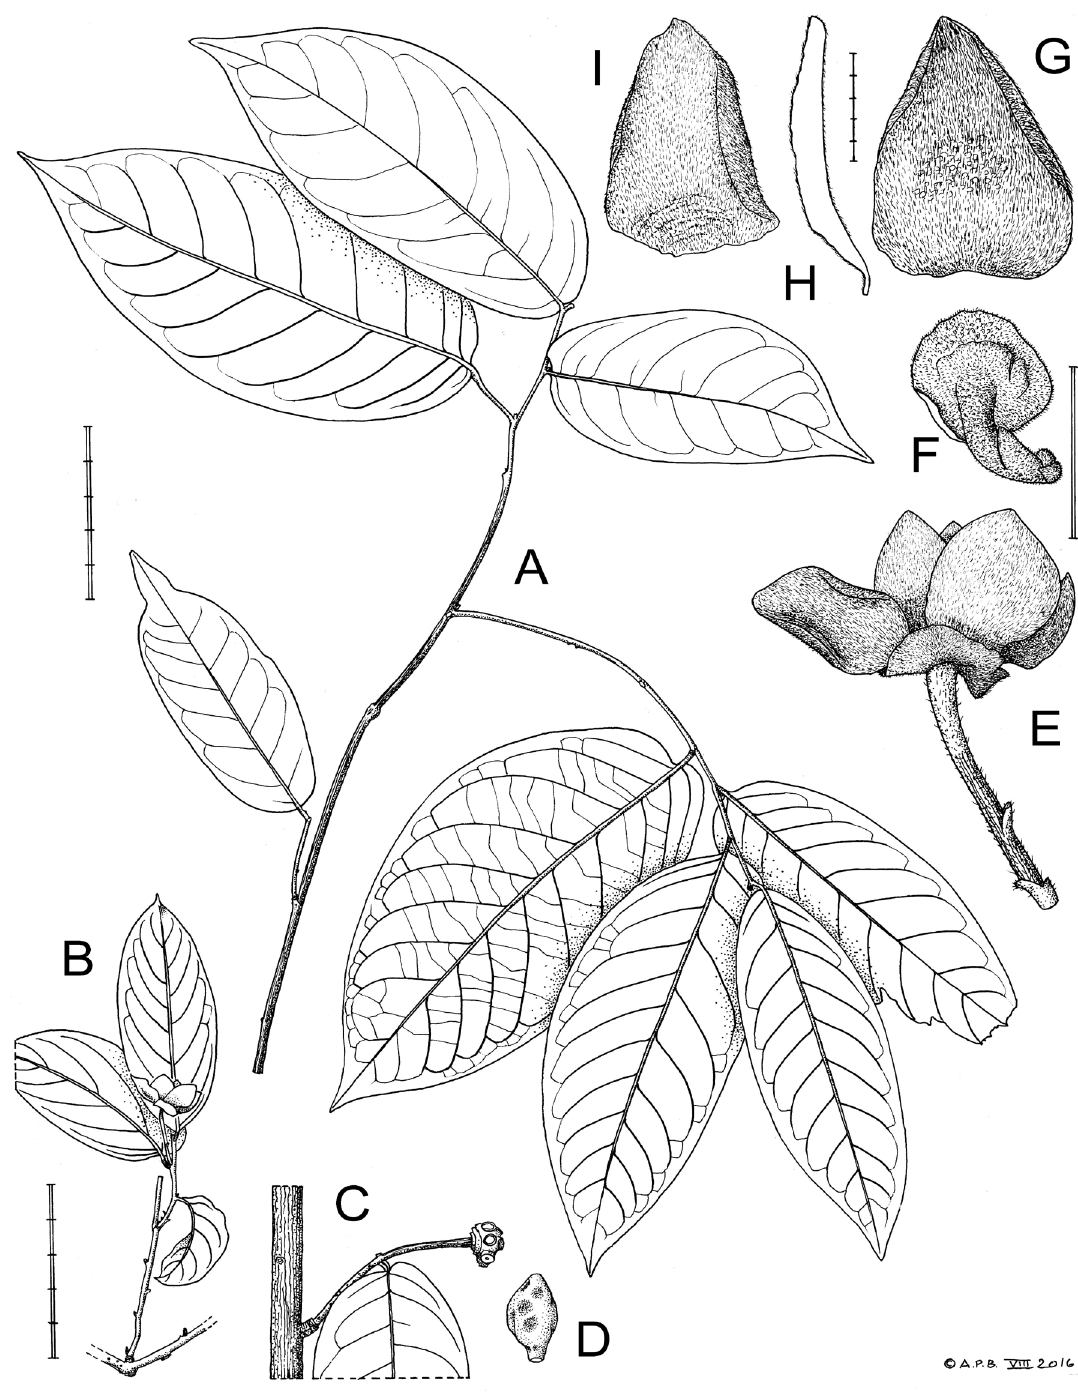
Fig. 1. Monoon pachypetalum I.M.Turner & Utteridge sp. nov. A . Foliage. B . Shoot bearing flower in leaf axil. C . Shoot bearing old fruit without monocarps. D . Detached monocarp. E . Flower, lateral view. F . Flower pedicel and calyx viewed from below. G . Outer petal, abaxial view. H . Median longitudinal section through outer petal. I . Inner petal, abaxial view. Scale bars: graduated single bar = 5 mm; double bar = 1 cm; graduated double bar = 5 cm. Drawn from Dransfield JD7565 (A, C, D); Nedi 781 (B, E); Gjellerup 738 (F–I). Drawn by Andrew